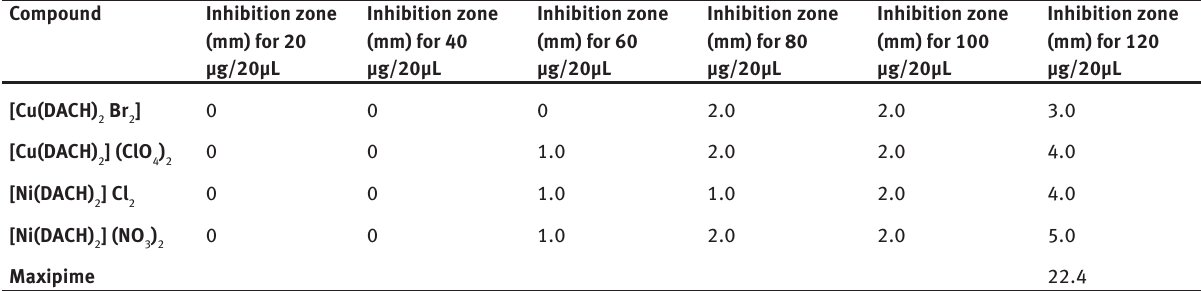
Table 8: Results of Antibacterial activity of the coordination complexes of DACH against Staphylococcus aureus.